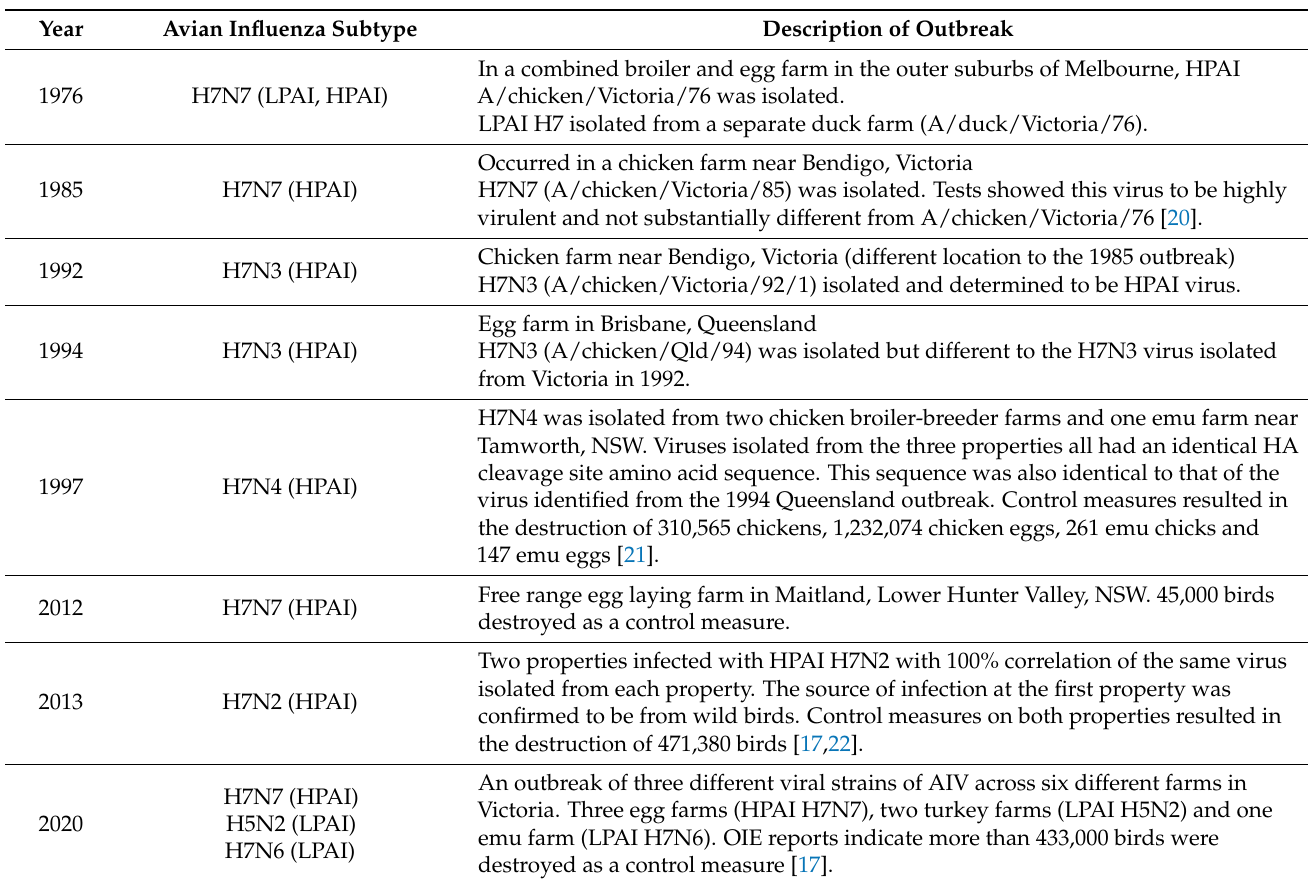
Table 2. Historical outbreaks of HPAI H7 subtypes in Australia since